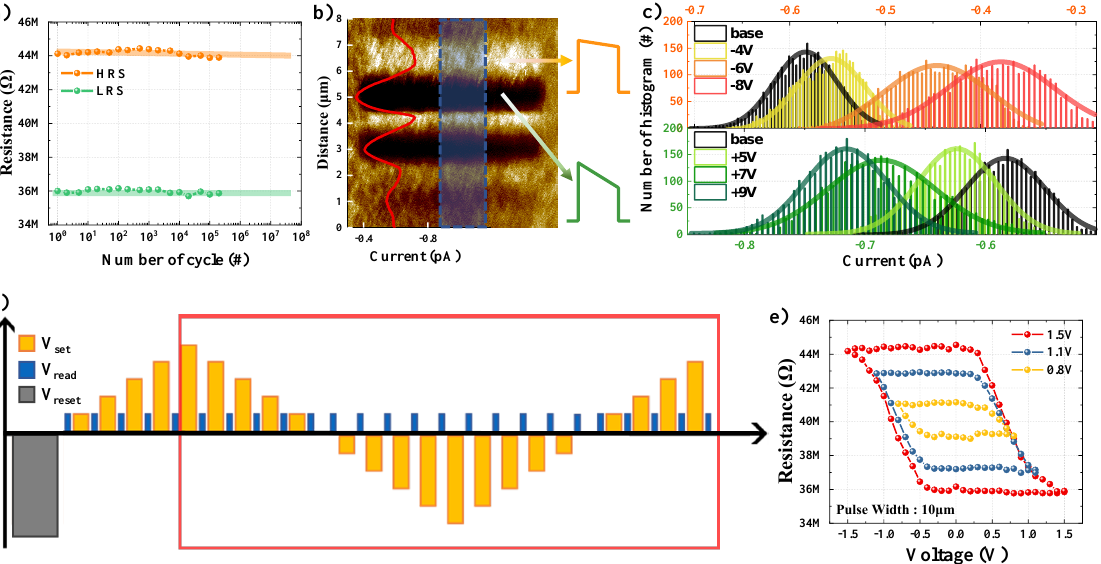
Figure 2. Verification of reproduced tunnelling electro-resistance (TER) effects and analog operating characteristics of HZO FTJ devices. ( a ) TER effects verification and reproducibility confirmation. ( b ) C-AFM image of the HZO/TiN structure. The inset data (red line) is the current mapping characteristics. The orange energy band diagram (EBD) corresponds to the high-resistance state (HRS), and the green EBD corresponds to the low-resistance state (LRS). ( c ) Current distributions of regions with different polarities and amplitudes of applied voltages: The HRS (right and upper panels) and LRS (right and lower panels) are the results from negative and positive voltages, respectively. ( d ) The sequences for the measurements of the R-V hysteresis loops with amplitude. ( e ) R–V hysteresis loops as function of pulse